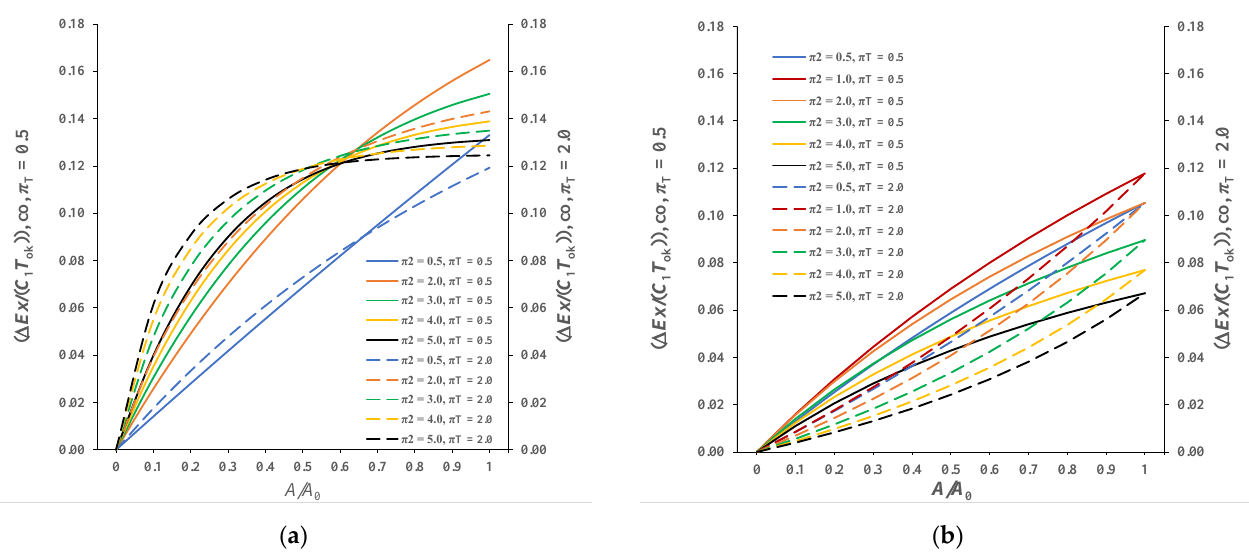
Figure 6. Local exergy destruction of a counter-flow recuperator for π T = 0.50 and 2.0: ( a ) π 3 = 0.50; ( b ) π 3 = 1.0.